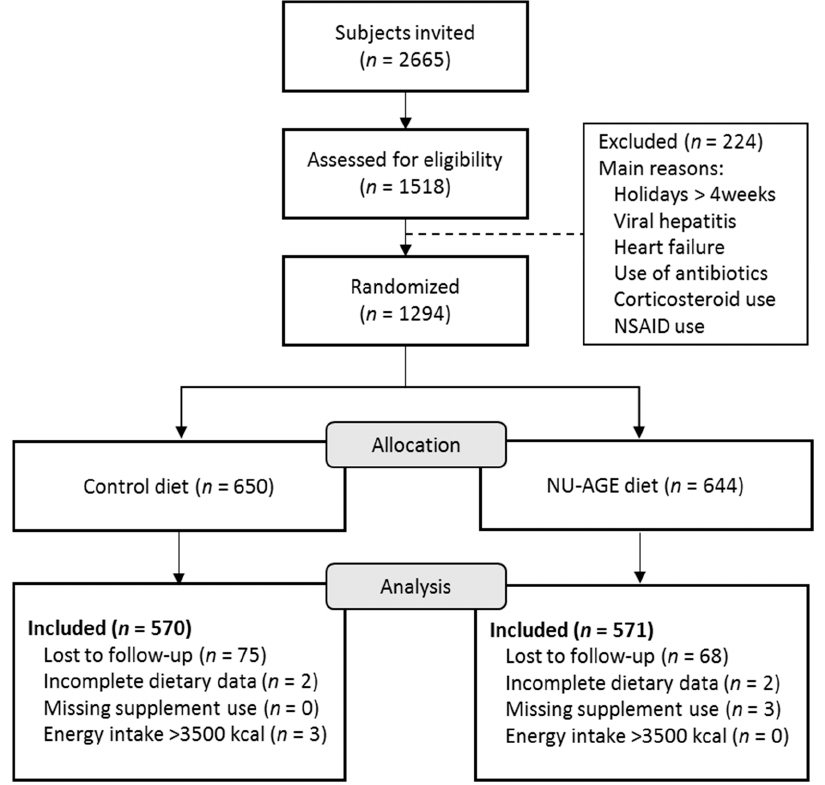
Figure 1. Flow chart of the recruitment process of participants in the NU-AGE dietary intervention study.